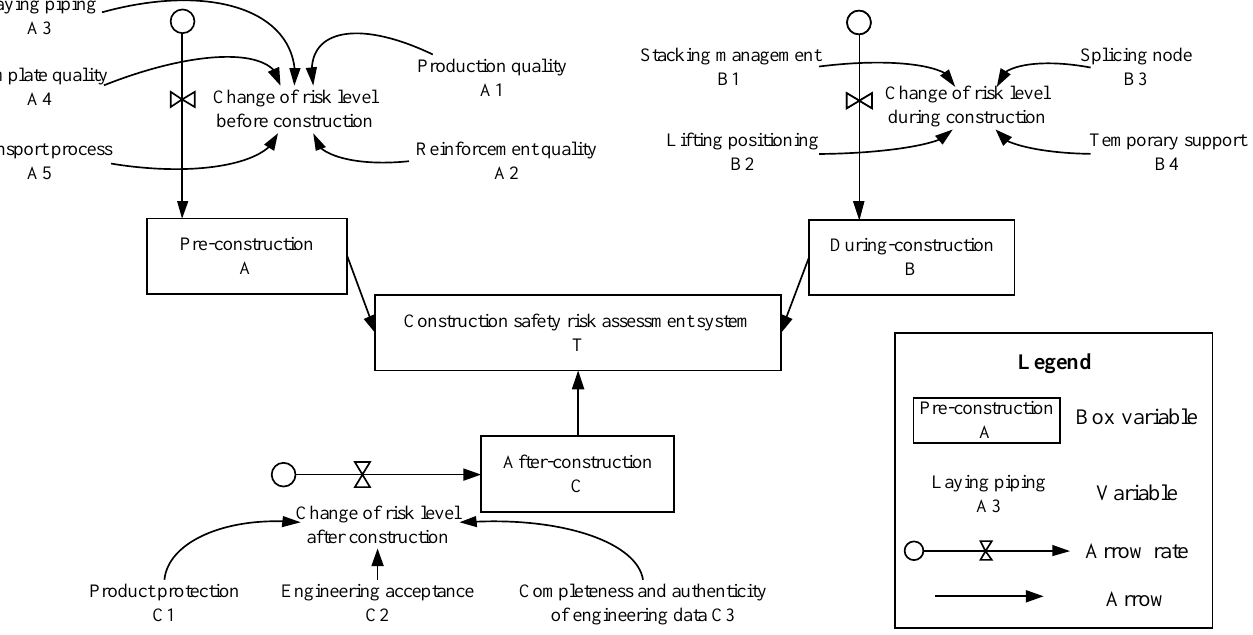
Figure 3. Inventory flow chart of construction safety risk factors.